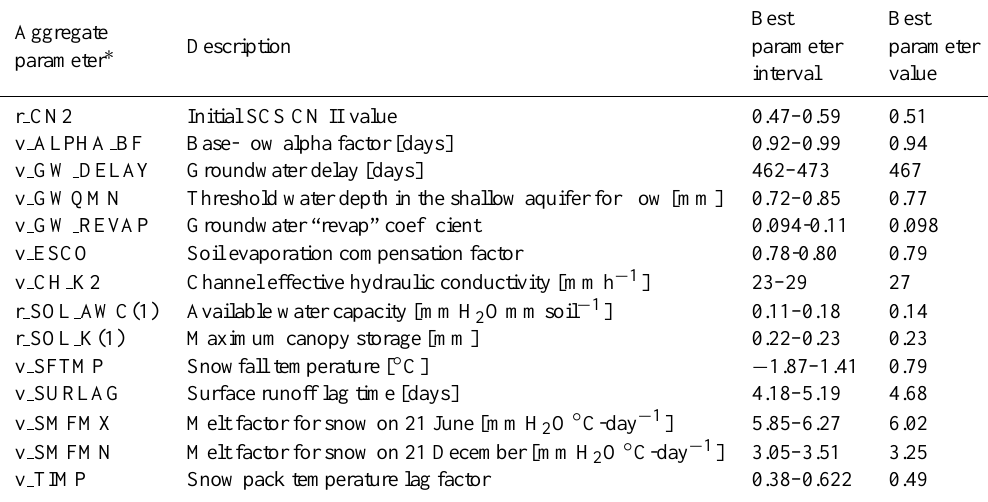
Table 1. The most sensitive parameters and their best parameter intervals and